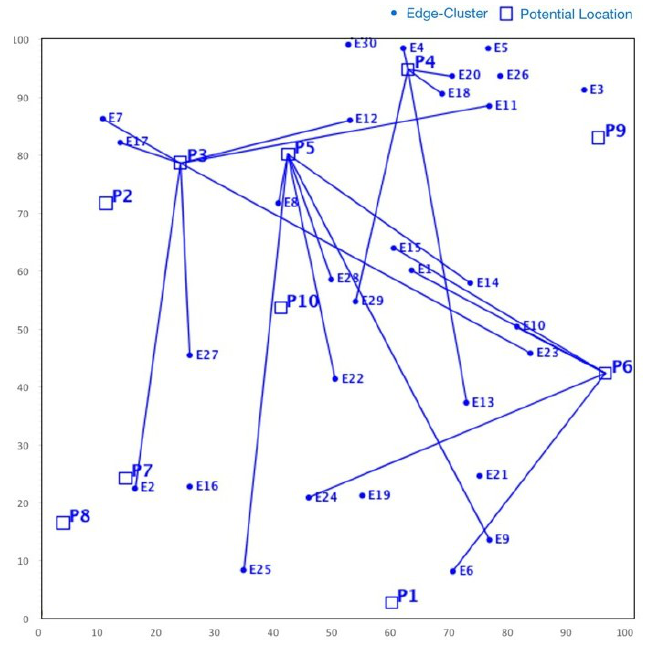
Figure 13. Output layout for SMPSO at e avg v = 77.31 units, τ avg v 324.4 ms.